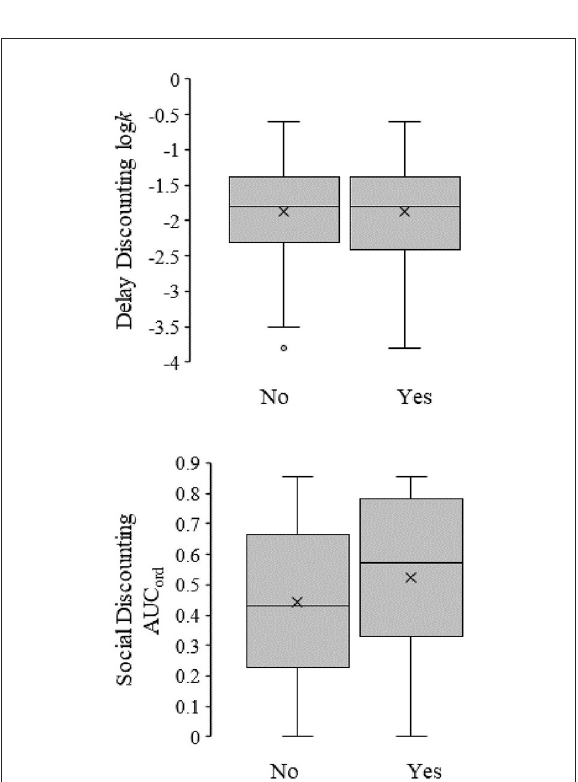
FIGURE1 Box-and-whisker plots for the relationship between delay (top figure) and social discount (bottom figure) rates and STI testing. The lower and upper bound for each box represents the first and third quartiles for discount rates, respectively. The horizontal lines bisecting each box represents the median discount rates. The X within each box represents the mean discount rate. Vertical lines extending above and below the box represent 1.5 times each interquartile range. Circles represent outliers. The left box represents individuals self-reporting no STI test ( n = 168), whereas the right box represents individuals self-reporting being tested for STIs ( n =